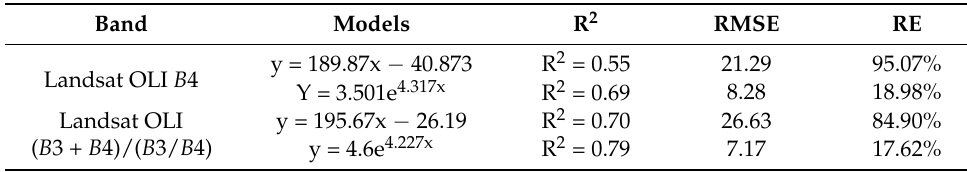
Table 3. The test results for the model accuracy